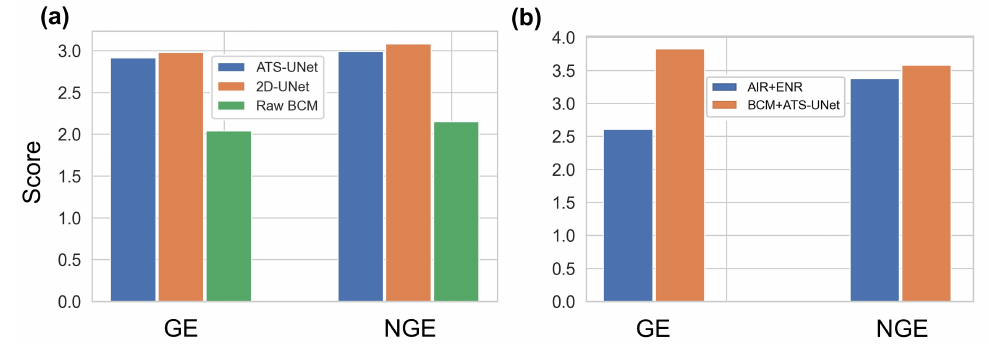
Figure 9. ( a , b ) The qualitative speech audio quality evaluation